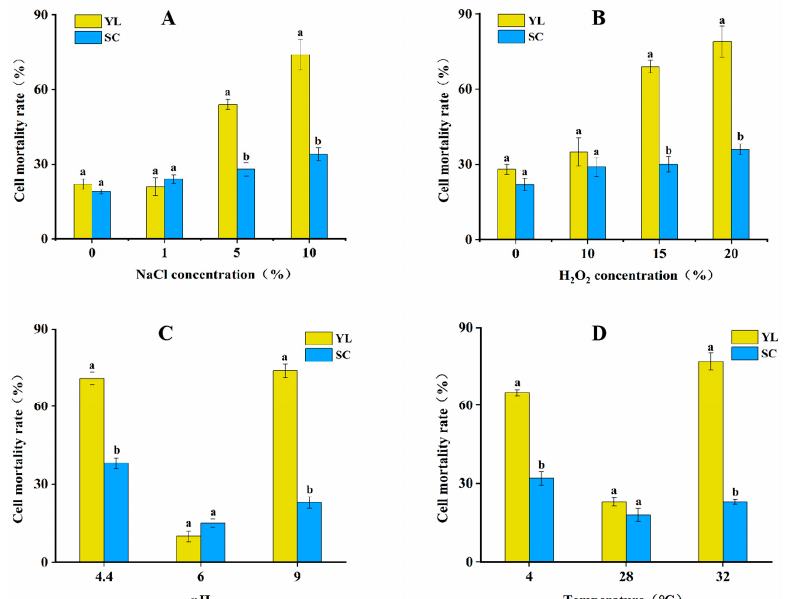
Figure 3. Survival of two types of cells in response to different external stress conditions. ( A ) Effect of NaCl treatment on the mortality of the two types of cells. ( B ) Effect of H 2 O 2 treatment on the mortality of the two types of cells. ( C ) Effect of pH change on the mortality of the two types of cells. ( D ) Effect of temperature on the mortality rate of both types of cells. Different letters represent significant differences between sample treatments ( p < 0.05).